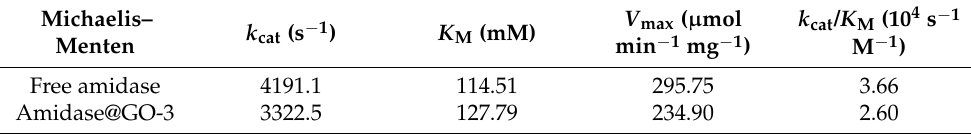
Table 1. Kinetic parameters of free amidase and